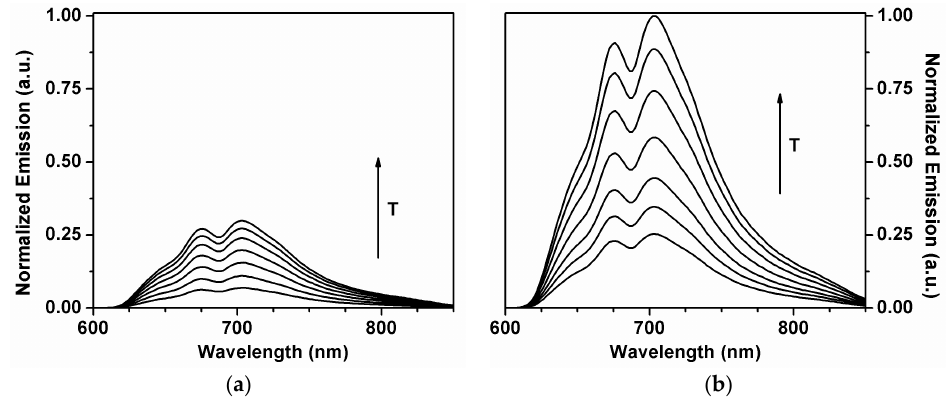
Figure 3. Dependence of TADF emission with the temperature for 12 C 70 ( a ) and 13 C 70 ( b ) in DHOC4 host medium.